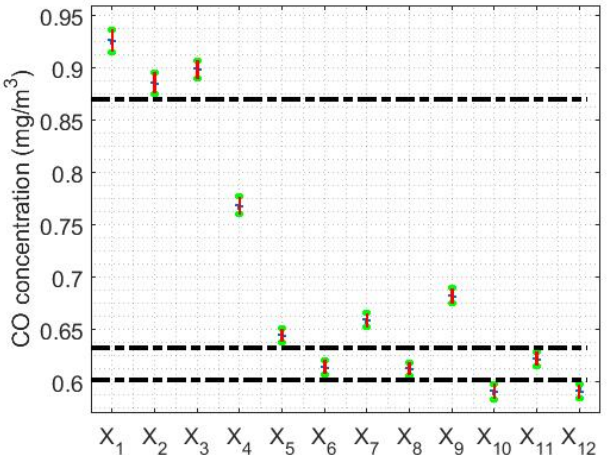
Figure 11. ( T bi ( 9 ) , s bi ( 9 )) 95% confidence intervals: X 1 ( 2008 ) , X 2 ( 2009 ) , X 3 ( 2010 ) , X 4 ( 2011 ) , Figure 11. (cid:3435) (cid:1846) (cid:1854)(cid:1861) ( 9 ) ,(cid:1871) (cid:1854)(cid:1861) ( 9 )(cid:3439) 95% confidence intervals: (cid:1850) (cid:2869) (2008) , (cid:1850) (cid:2870) (2009) , (cid:1850) (cid:2871) (2010) , (cid:1850) (cid:2872) (2011) , (cid:1850) (cid:2873) (2012) , (cid:1850) (cid:2874) (2013) , (cid:1850) (cid:2875) (2014) , (cid:1850) (cid:2876) (2015) , (cid:1850) (cid:2877) (2016) , (cid:1850) (cid:2869)(cid:2868) (2017) , (cid:1850) (cid:2869)(cid:2869) (2018) , and (cid:1850) (cid:2869)(cid:2870) (2019) . X 5 ( 2012 ) , X 6 ( 2013 ) , X 7 ( 2014 ) , X 8 ( 2015 ) , X 9 ( 2016 ) , X 10 ( 2017 ) , X 11 ( 2018 ) , and X 12 ( 2019 )